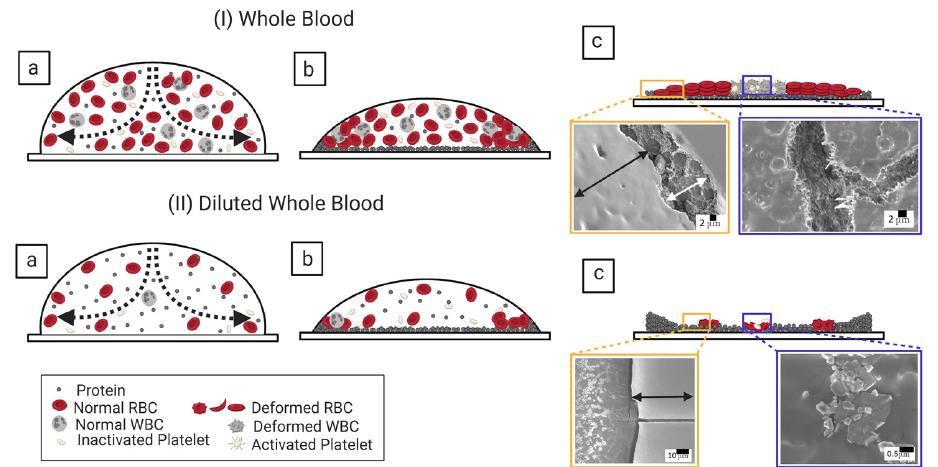
Figure 14. Self-assembling mechanism of the undiluted and the diluted blood droplets during the drying process. The φ b of 100% ( v / v ) is displayed in (( I )a–c), and the 12.5% ( v / v ) is exhibited in (( II )a–c). The dotted arrows in (( I , II )a) indicates the capillary flow of the fluid. The blue rectangles in (( I , II )c) display the central region’s microstructures for both 100 and 12.5% ( v / v ). The orange rectangle in (( I )c) illustrates the periphery and the corona (or the ring) regions at φ b = 100% ( v / v ). The corona and the central regions are presented within the orange rectangle in (( II )c). The white arrow reveals the peripheral region, whereas the black arrow demonstrates the ring.